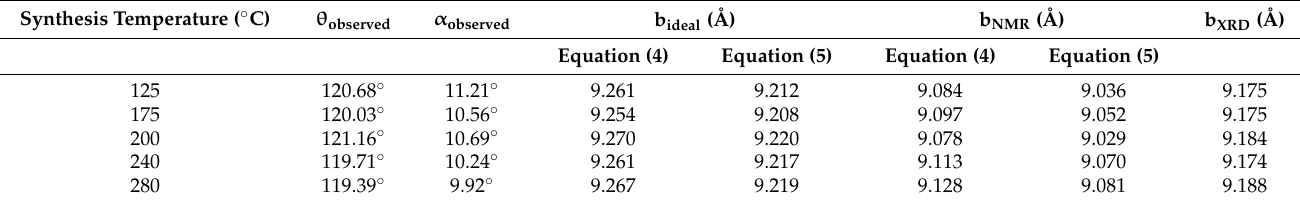
Table 4. 29 Si MAS-NMR data and structural parameters, based on the Equations (2)–(5) of synthetic NH 4 -saponites prepared with increasing hydrothermal temperatures (modified after